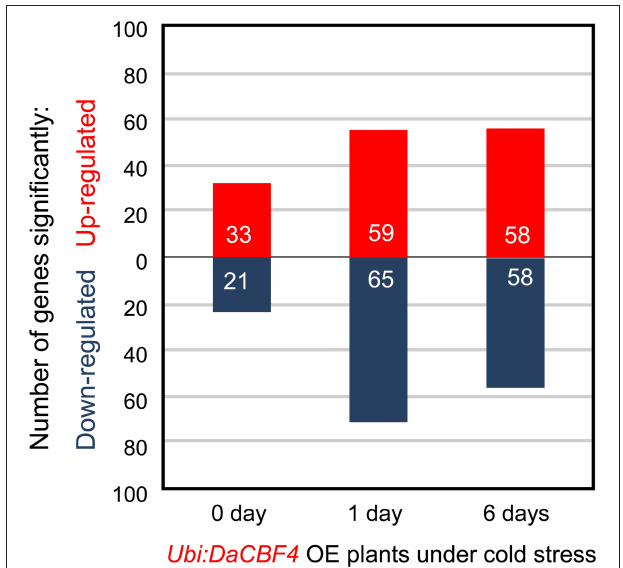
FIGURE 5 | Transcriptome analysis with RNA-seq of the cold-stress response of Ubi:DaCBF4 transgenic plants. Number of differentially expressed genes in Ubi:DaCBF4 line #1 relative to the expression level of wild-type (WT) at each time point (0, 1, and 6 days) of cold treatment ( p < 0.05, corrected p -value of FDR <